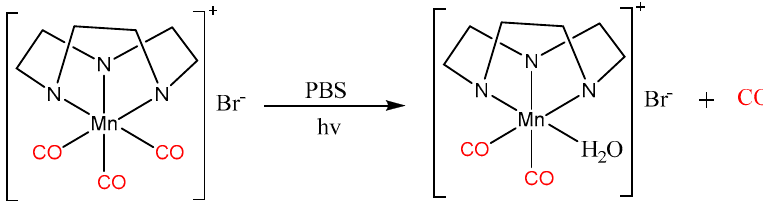
Figure24. Photo-activatedALF472CORM[Mn(tacn)(CO) 3 Figure 24. Photo ‐ activated ALF472 CORM [Mn(tacn)(CO) 3 ]Br simulated under physiological parameter.